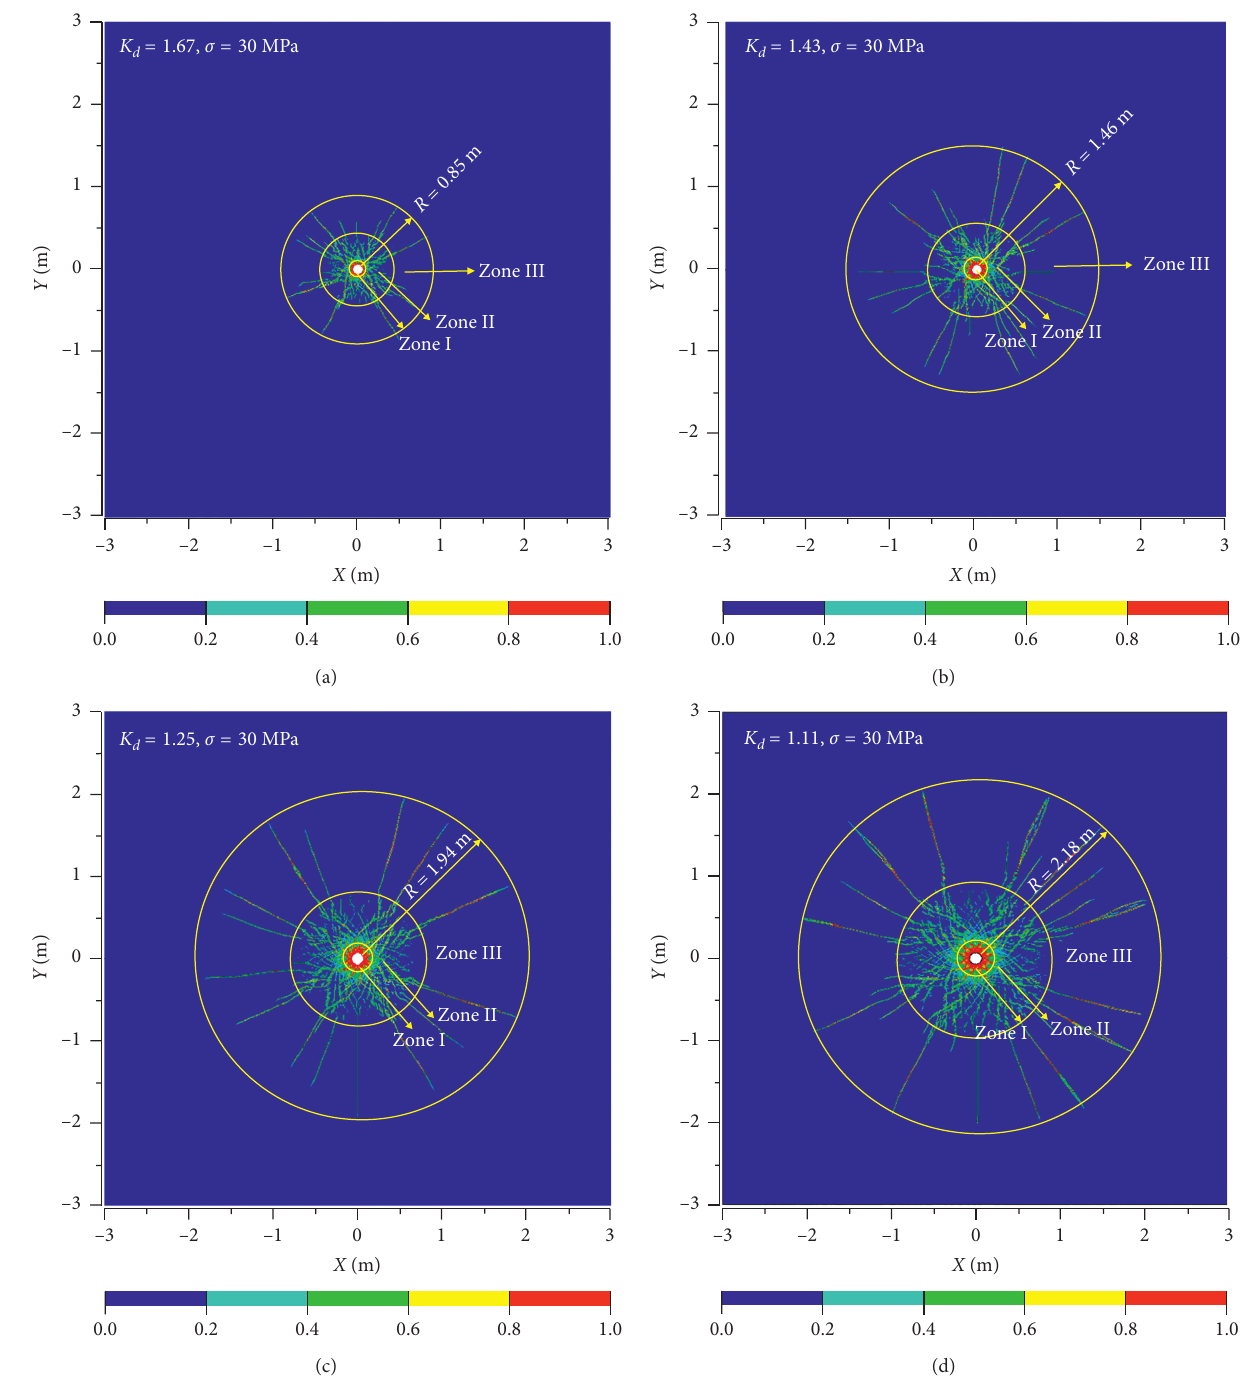
Figure 16: Crack patterns with different decoupling coefficients under hydrostatic pressure 30MPa: (a) K K d � 1.25; (d) K d �